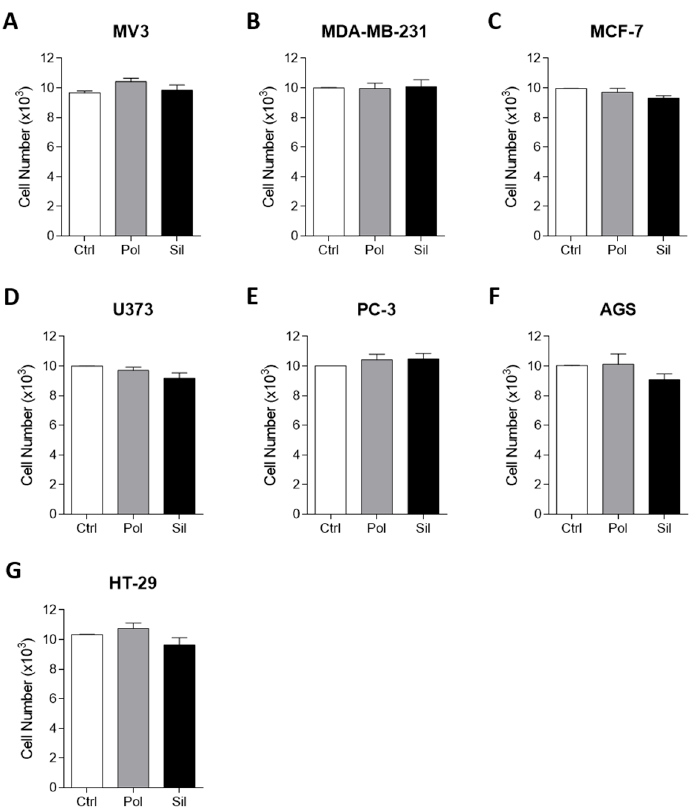
Figure 3. Nanoparticle effects on tumor cytotoxicity. Tumor cells were incubated with polymeric or silica nanoparticles (20 μ g/mL) for 24 hs. Cytotoxicity was evaluated using the 3-(4,5-dimethylthiazol- 2-yl)-2,5-diphenyltetrazolium bromide MTT assay. A. MV3 (human melanoma cancer cell line) B. MDA-MB-231 (human triple negative breast cancer cell line) C. MCF-7 (human breast cancer cell line) D. U373 (human glioblastoma cell line) E. PC-3 (human prostate cancer cell line) F. AGS (human gastric cancer cell line) G. HT-29 (human colon cancer cell line). Results are presented as the mean ± SD calculated from three individual experiments (* p < 0.05).